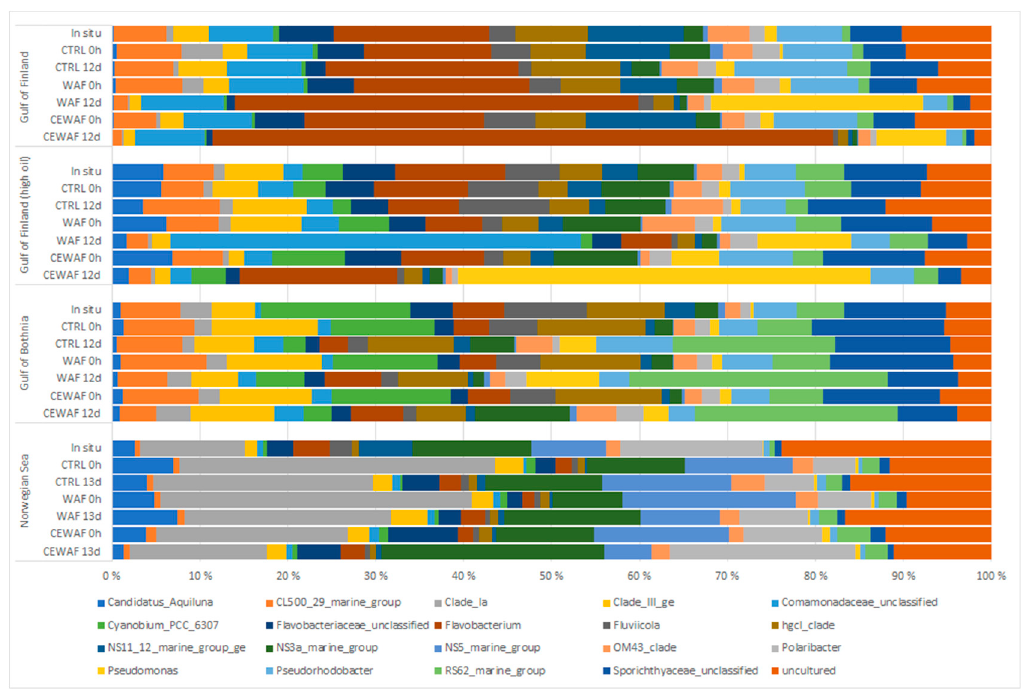
Figure 10. Heatmap of the top 20 most abundant bacterial genera in different experiments and treat- ments (average of three replicates). NS indicates the Norwegian Sea, GoB indicates the Gulf of Both- nia and GoF indicates the Gulf of Finland.